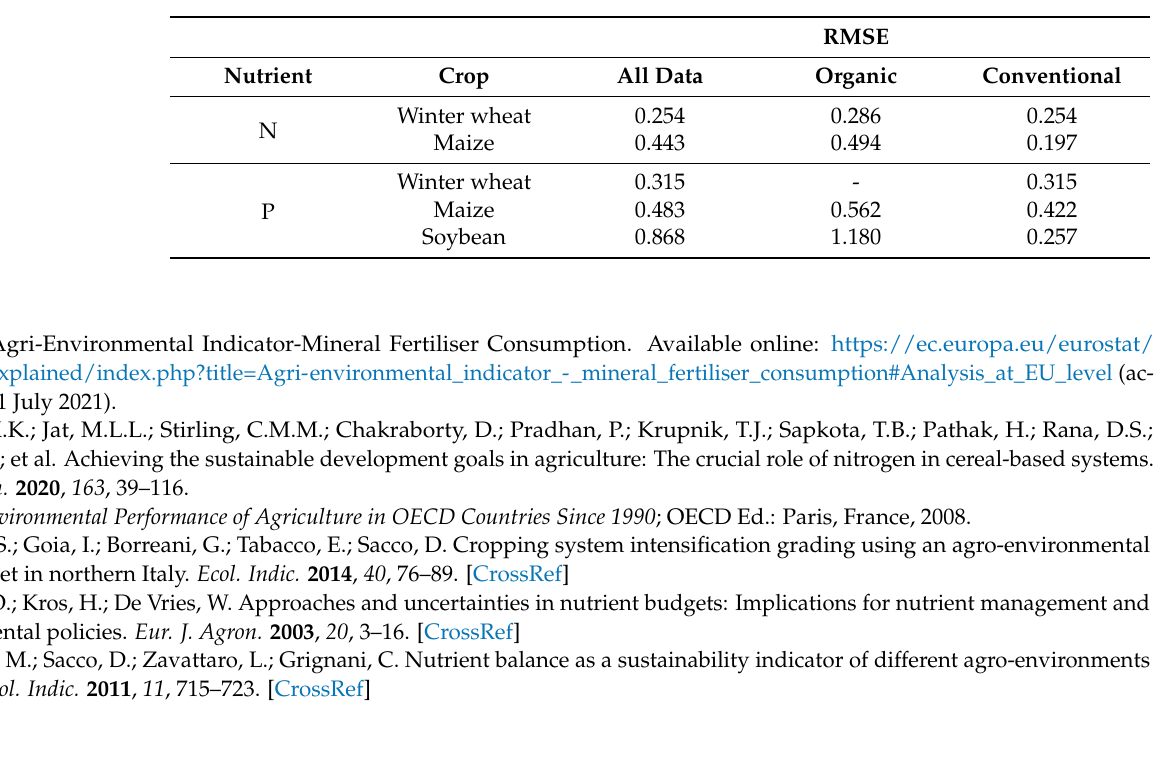
Table A7. The root means square error (RMSE) represents the goodness of fit of the long-term experiment-based hyperbolic model under real-field